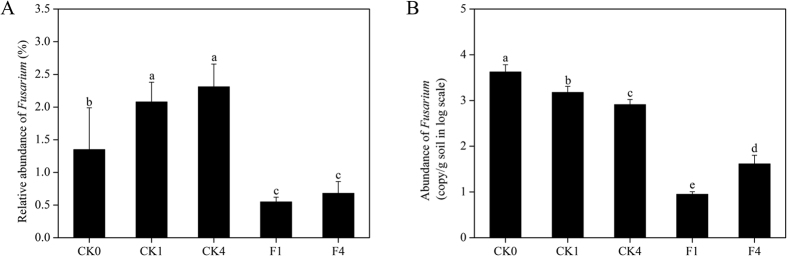
Abundance of Fusarium in F (fumigation) and CK (control) treatments.(A) Relative abundance of Fusarium based on high throughput sequencing data. (B) The copy number of Fusarium was calculated according to Fusarium abundance × fungal copy number. The significance of the difference was determined by one-way ANOVA (n = 6). Bars shared the same character represent a lack of significant difference (p > 0.05).